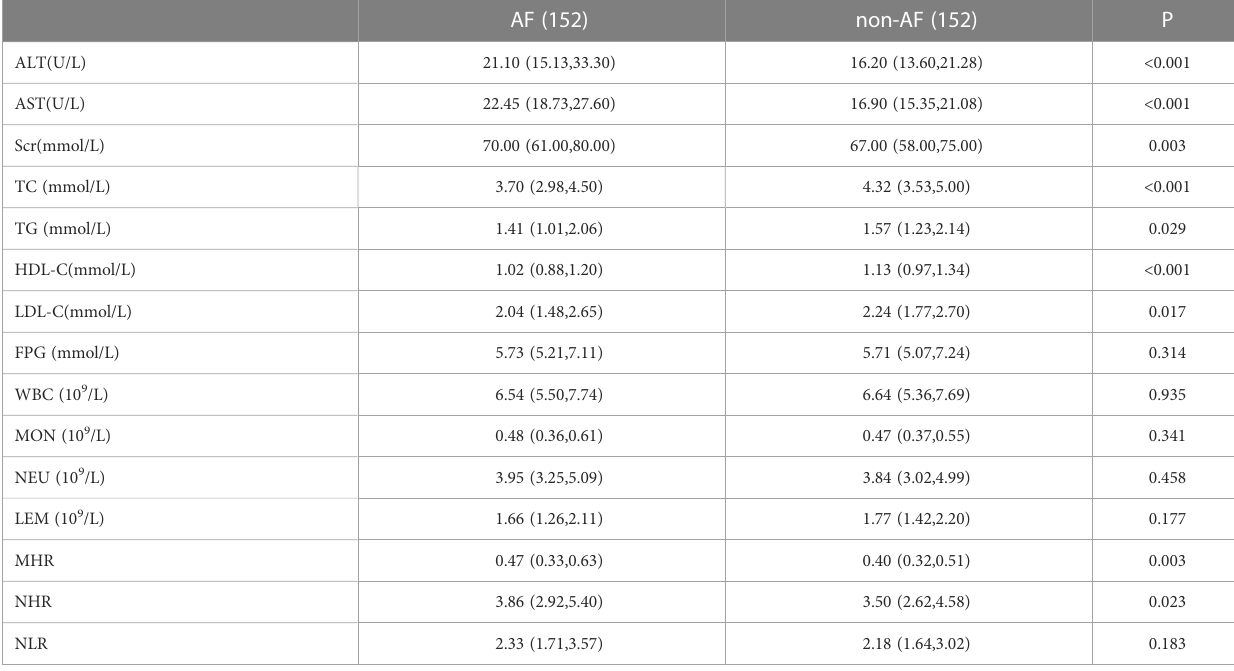
TABLE 2 Laboratory indicators in patients with AF and non-AF.